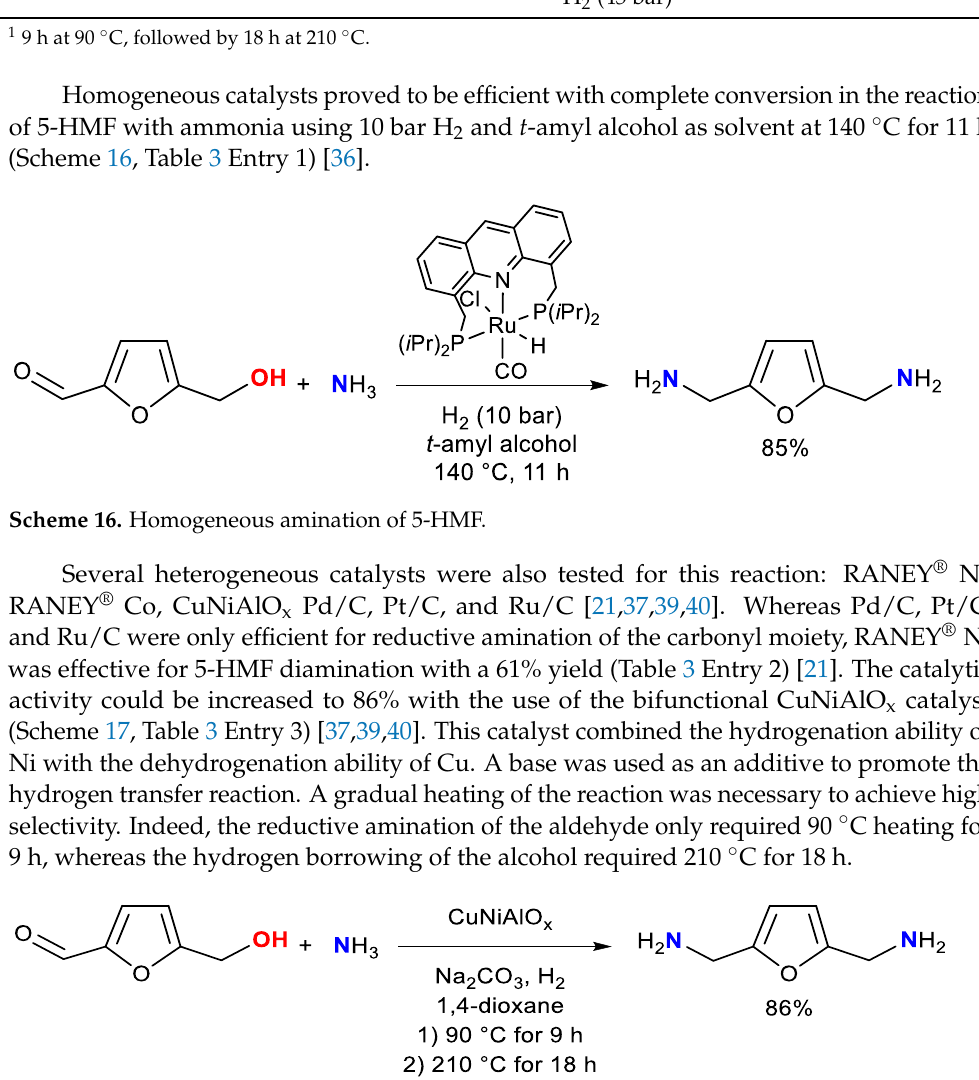
Table 3. Catalytic amination of 5-HMF with ammonia as a nitrogen source to produce